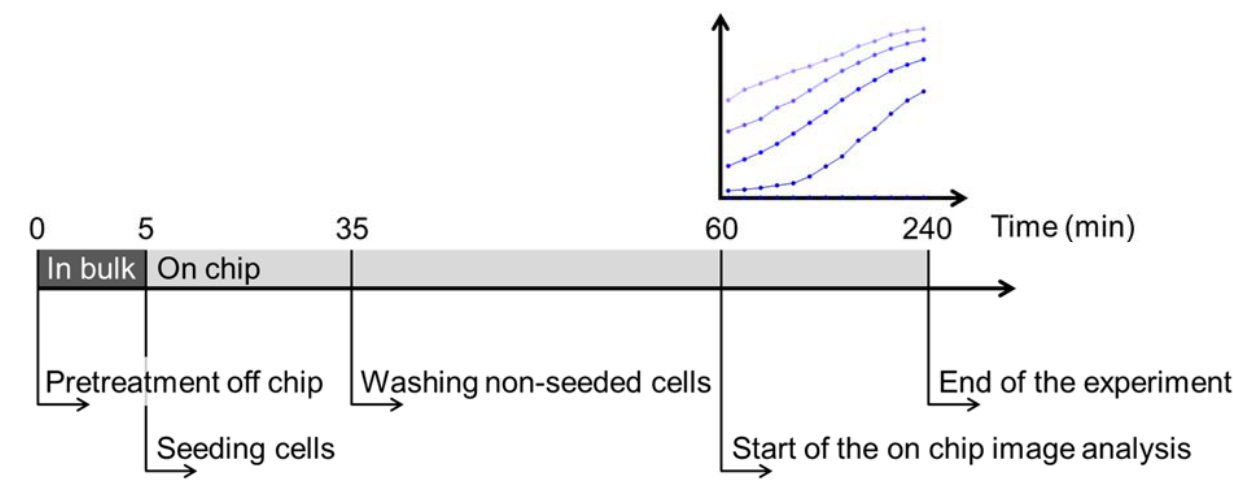
Figure 1. Schematic overview of the timing of single cell experiments using the optimized continuous microfluidic platform with a PEG-grafted OSTE+ microwell array. Cells are pretreated in bulk with HsAFP1 during 5 min, after which cells are seeded on-chip (30 min). After the seeding step, non-seeded cells are washed (15 min), followed by the start of the on-chip image analysis from 60 min onwards. The kinetics of cellular events is monitored during 3 h on-chip, equaling 4 h of treatment of cells with HsAFP1. The percentages of PI-positive cells obtained using flow cytometry and the